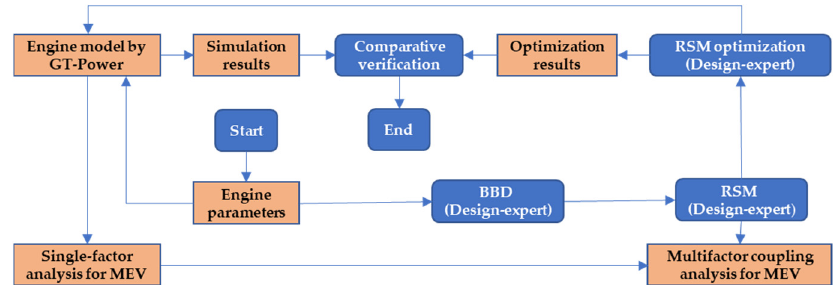
Figure 1. Research